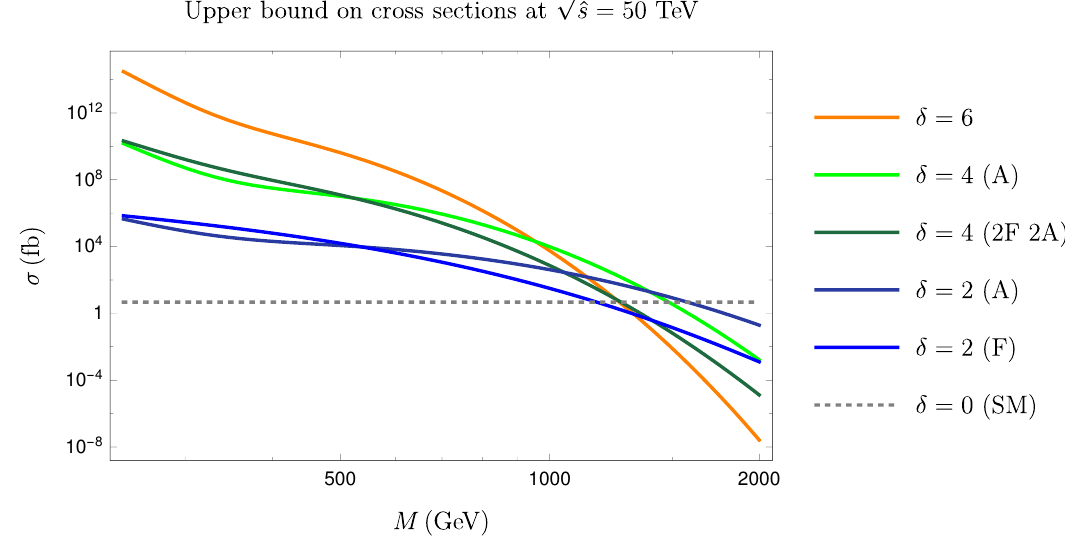
Figure 6. Upper bounds on the cross sections in di(cid:11)erent